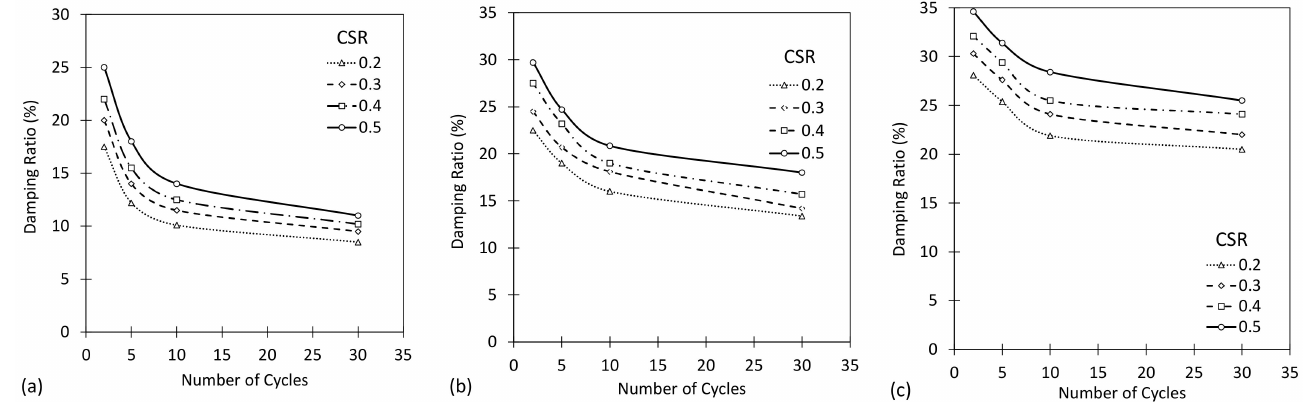
Figure 8. Effects of increasing number of loading cycles on the damping ratio for different CSR conditions and vertical stresses of ( a ) 50 kPa, ( b ) 150 kPa and ( c ) 250 kPa for the first reconstruction.